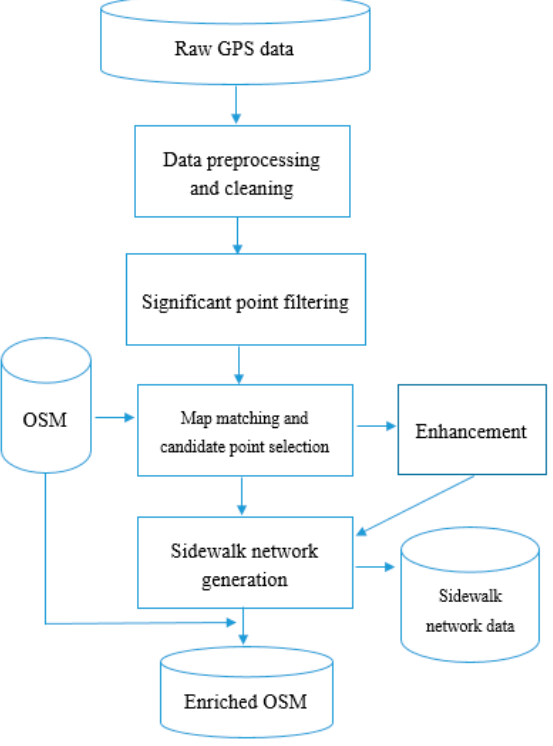
Figure 1. Workflow of the methodology.